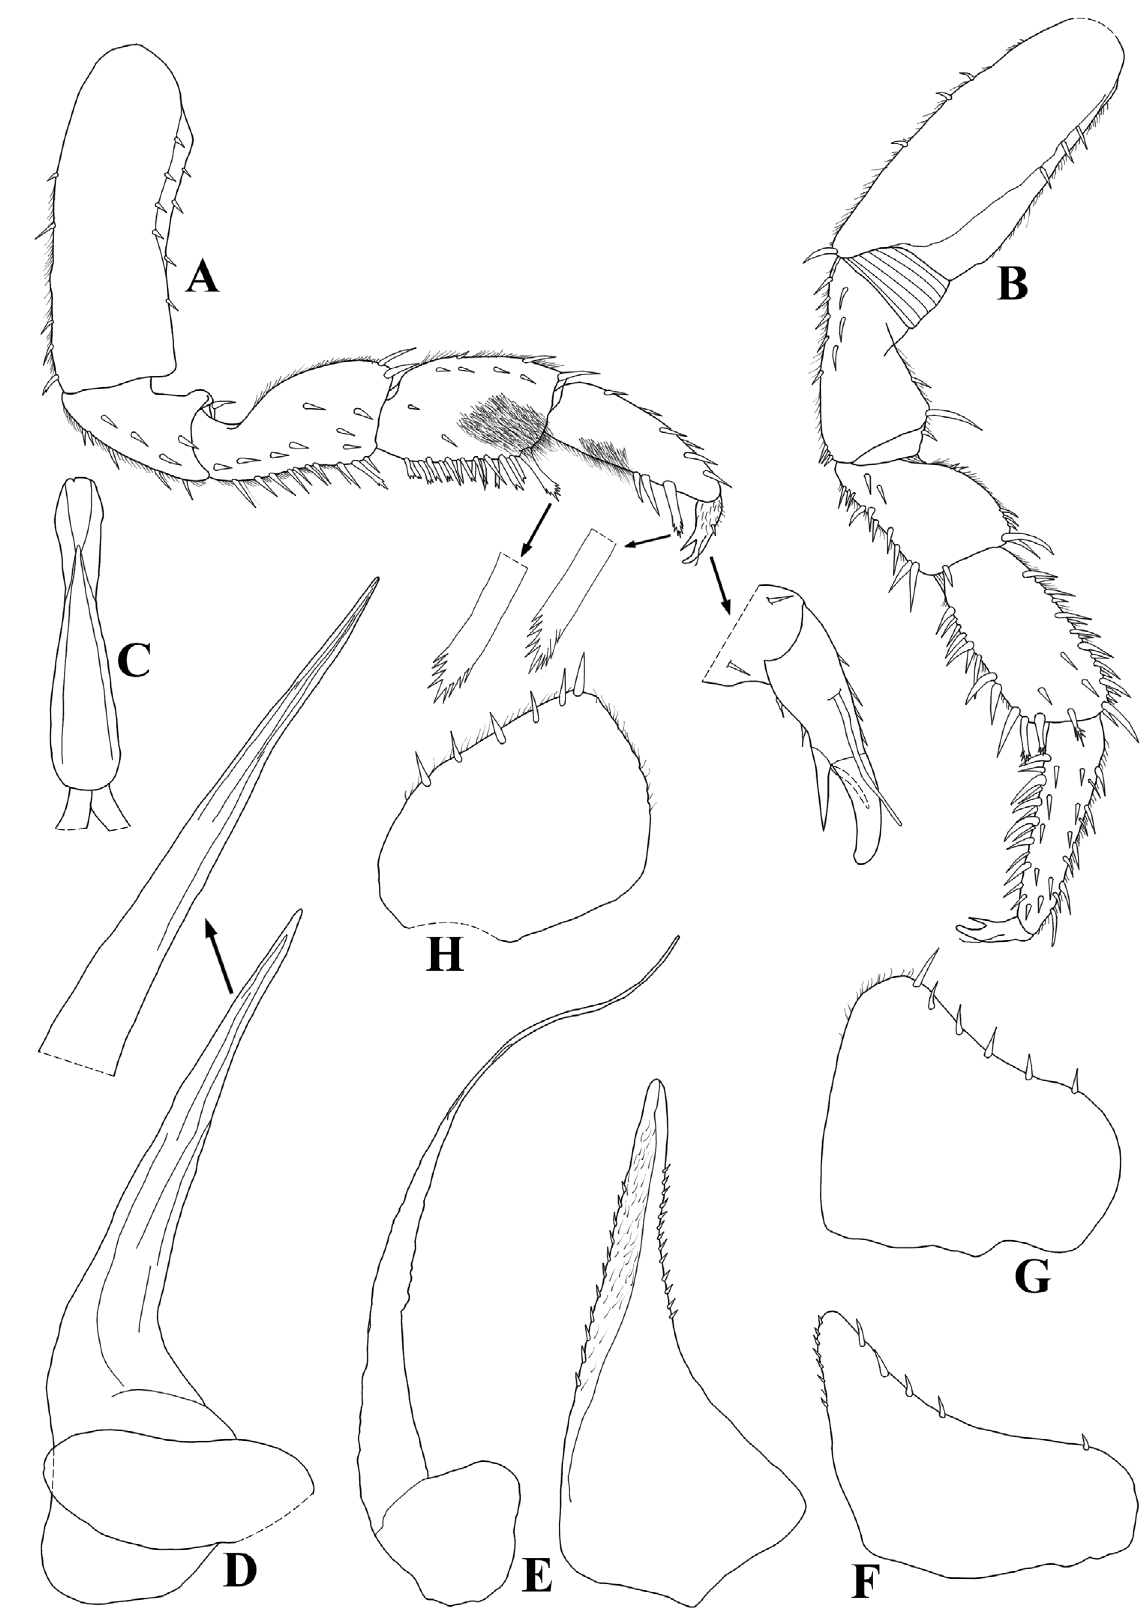
Figure 3. Trichorhina navasi López-Orozco, Carpio-Díaz and Campos-Filho n. sp., (male paratype). A , pereopod 1; B , pereopod 7; C , genital papilla; D , pleopod 1; E , pleopod 2; F , pleopod 3 exopod; G , pleopod 4 exopod; H , pleopod 5